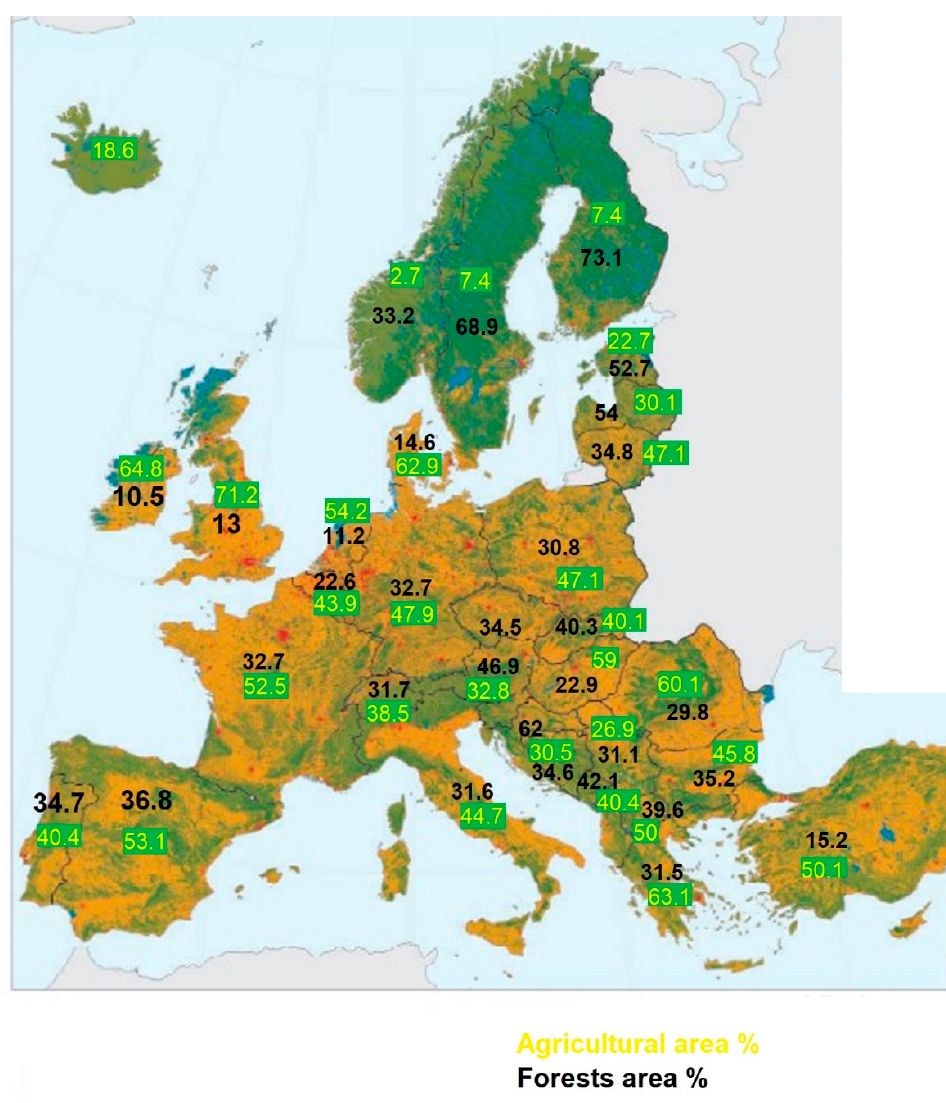
Figure 4. The area potential for agricultural and forest biomass in the EU member-states. Source: [106].